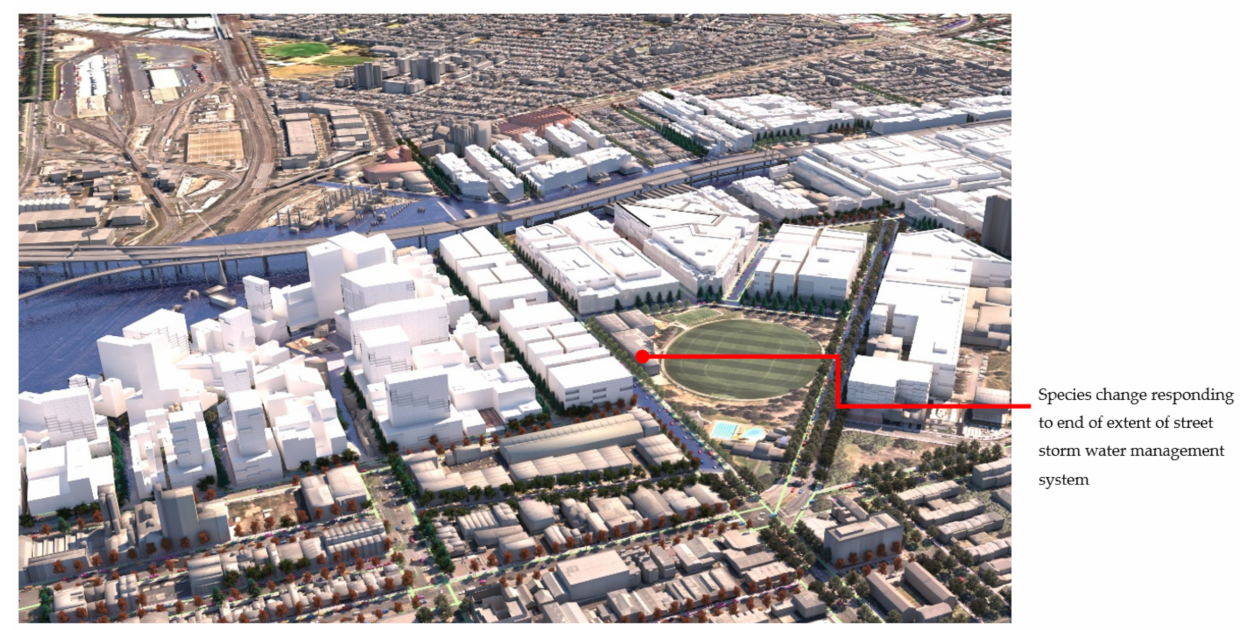
Figure 13. Rendering, aerial view north-west under flood condition for scenario (2), road-based integrated water management. Image by authors using multi-criteria street tree design decision support modelling approach in Autodesk™ 3ds Max™.